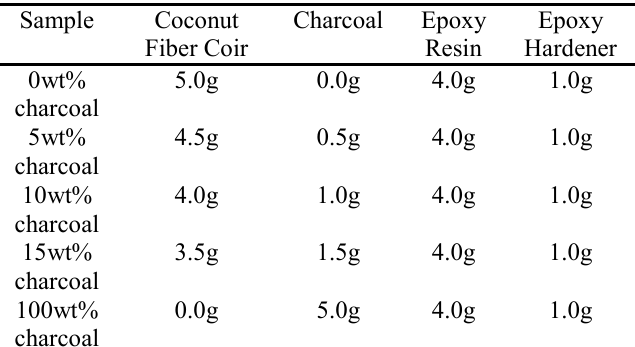
Table 1 : Compositions of each sample